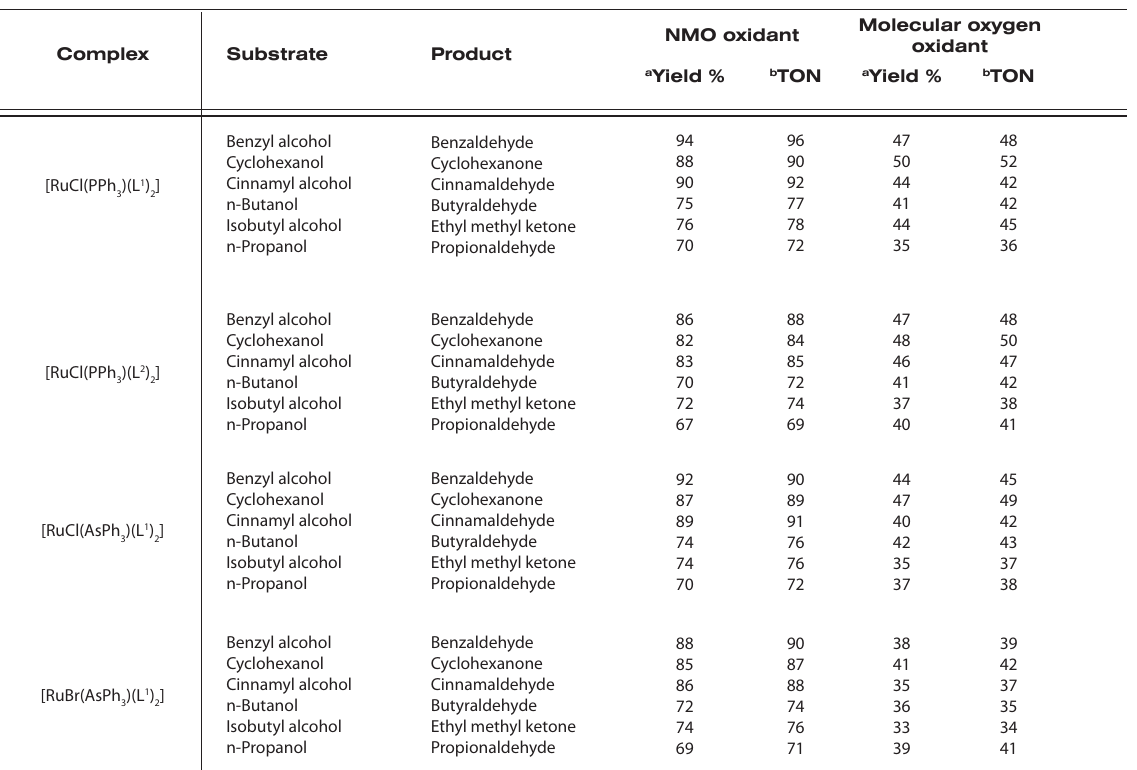
Table 5. Oxidation of alcohols by ruthenium(III) complexes